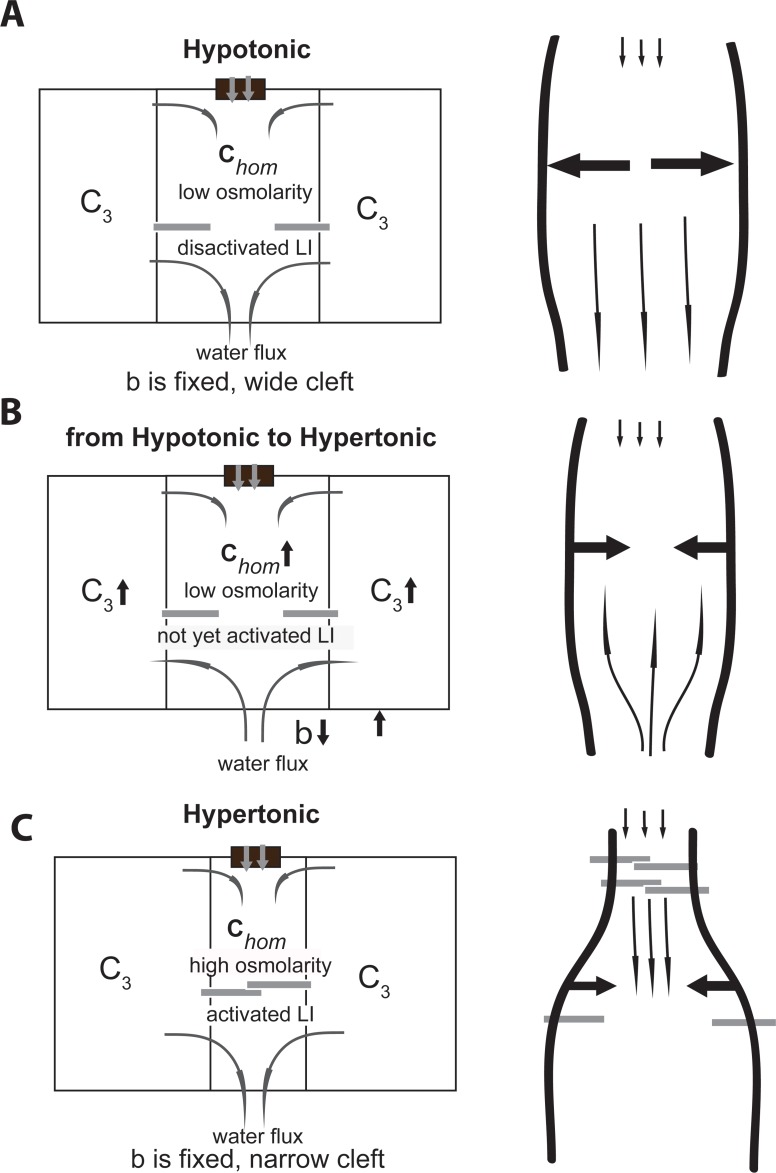
The potential mechanism by which LI-cadherins can squeeze water out of the IC in the course of lumen osmolarity change is introduced schematically.(A) The cleft is wide as LI-cadherins are in deactivated state. (B) Change from hypotomic to hypertonic conditions. LI-cadherins are not yet activated, the internal cell c3 and the homogeneous concentrations increase. Water flux in the negative direction and through lateral membrane is present. (C) LI-cadherins are activated as the homogeneous concentration chom reaches a certain value–LI activation causes the water to be squeezed downwards.